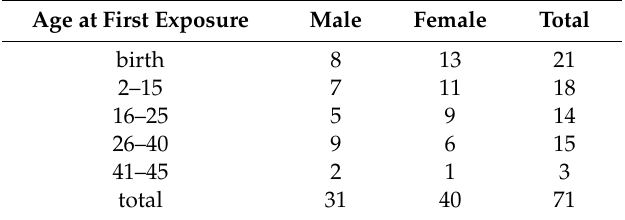
Table 4. The overall distribution of age at the start of exposure and sex is as follows.